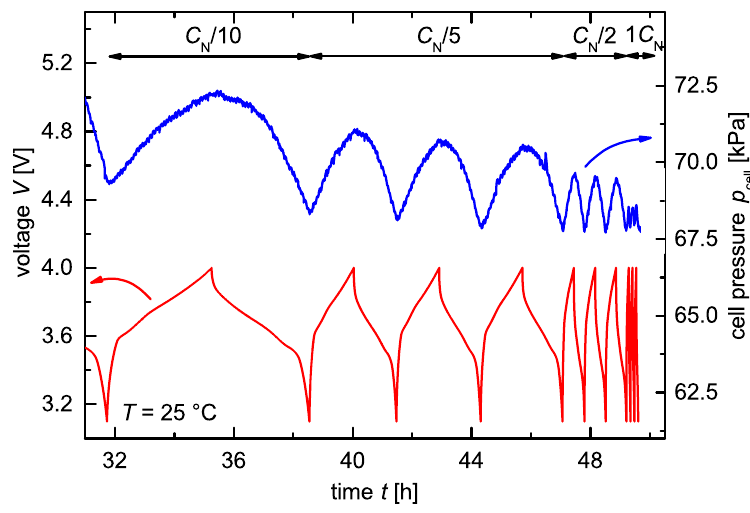
Figure 5. Pressure-time and voltage-time curves of a constrained NCM/graphite coin cell at several C-rates using a pressure monitoring cell for constrained battery electrodes. The cell pressure p cell correlates with the voltage V of the electrochemical cell. The pressure difference during cycling decreases with increasing